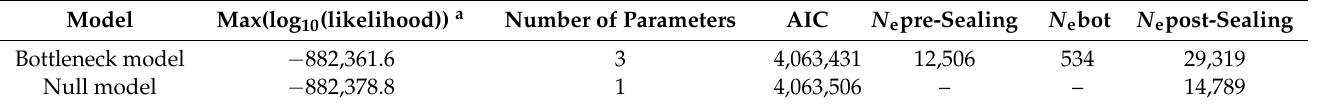
Table 1. Relative likelihoods of the two alternative demographic models together with AIC values and parameter estimates for the pre-sealing effective population size ( N e pre-sealing), the bottleneck effective population size ( N e bot), and the post-sealing effective population size ( N e post-sealing). See the Materials and methods for details.